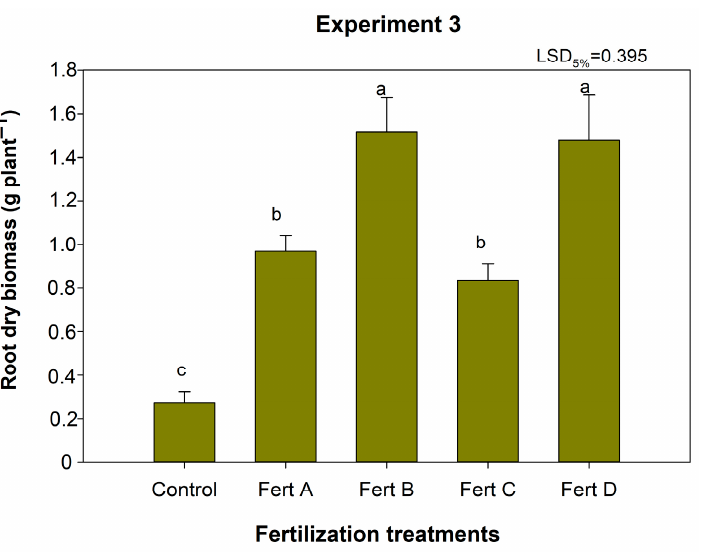
Figure 9. Root dry biomass (g plant − 1 ) of bristly oxtongue plants as affected by various fertilization regimes. For each sampling date, bars followed by the same letters were not shown to significantly differ with Fisher’s least significant difference (LSD) test. The error bars show the Standard Error values. Final measurement (source of variation: treatments): Fvalue = 17.896, p < 0.001, DF (degrees of freedom) = 4.